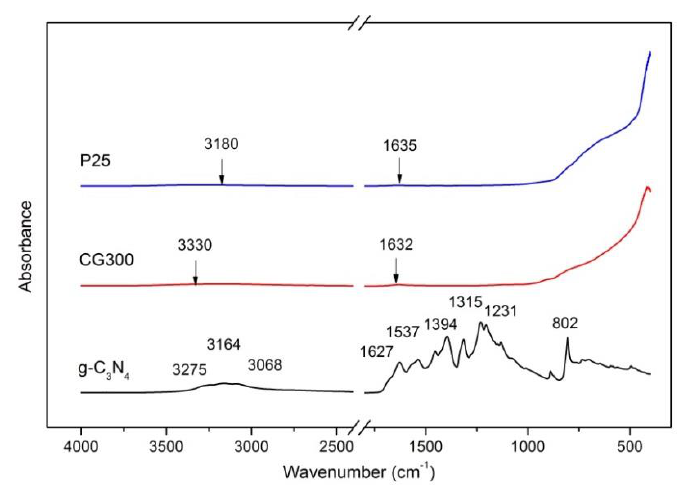
Figure 3. FTIR–ATR spectrum of the tested nanomaterials.